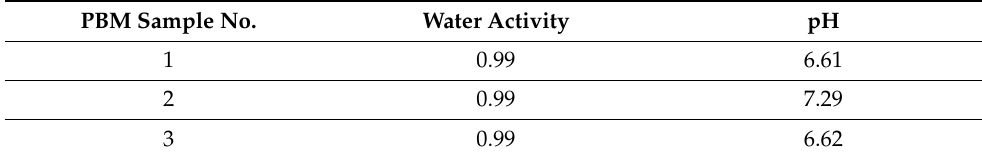
Table 1. Water activity and pH of thawed PBM samples. PBM Sample